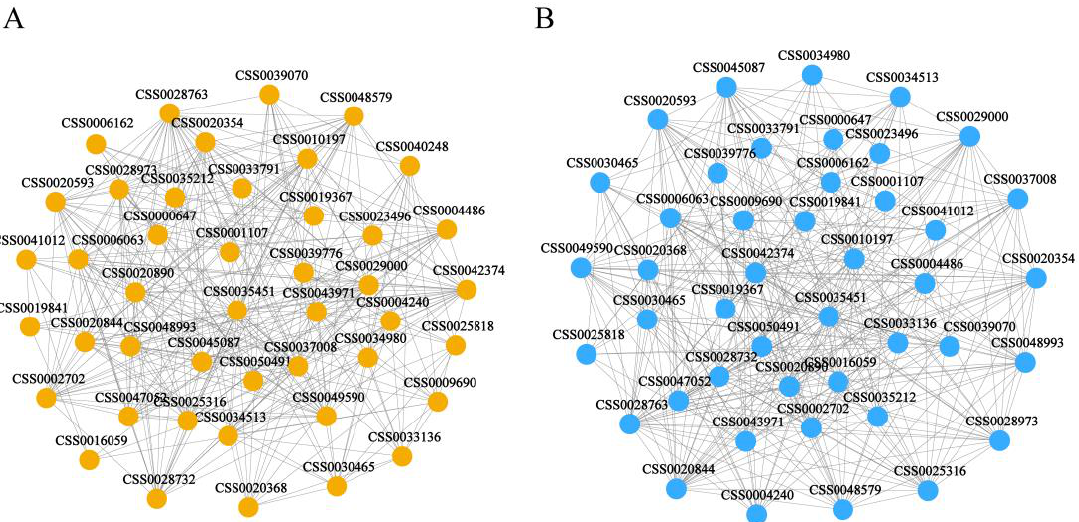
Figure 7. Co-expression analysis of DEGs identified in both Cd / As-treated tea roots. ( A ) Co-expression analysis of DEGs identified in Cd-treated tea roots;( B ) Co-expression analysis of DEGs identified in As-treated tea roots. Nodes represent ‘genes’ and edges represent ‘relationships’ between any two genes. It was determined by a Pearson correlation coefficient > 0.80 or a Pearson correlation coefficient < − 0.80,